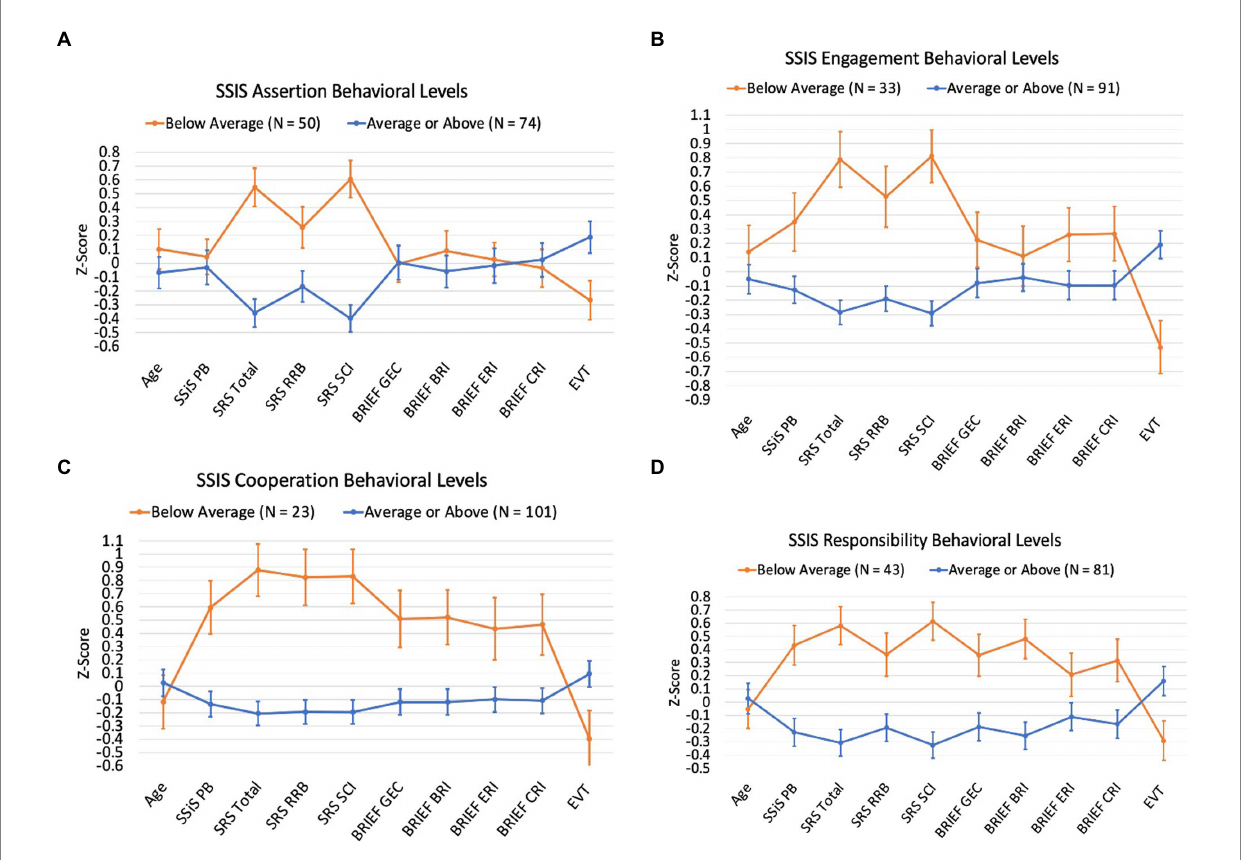
FIGURE 3 Participant scores across study measures by SSiS Social Skills subscale behavioral